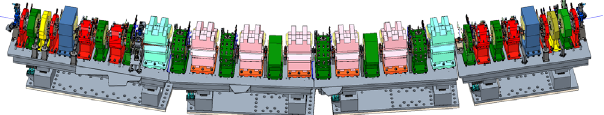
FIG. 3. Illustration of how roll and offset errors stack up in the implementation of the SR misalignment error model. Note that each full sector is assigned an offset, girders in a sector are assigned offsets relative to their sector, and individual magnets are assigned offsets relative to the girder on which they are mounted. The girder yaw and pitch angles are derived from the specification of the offsets at the girder